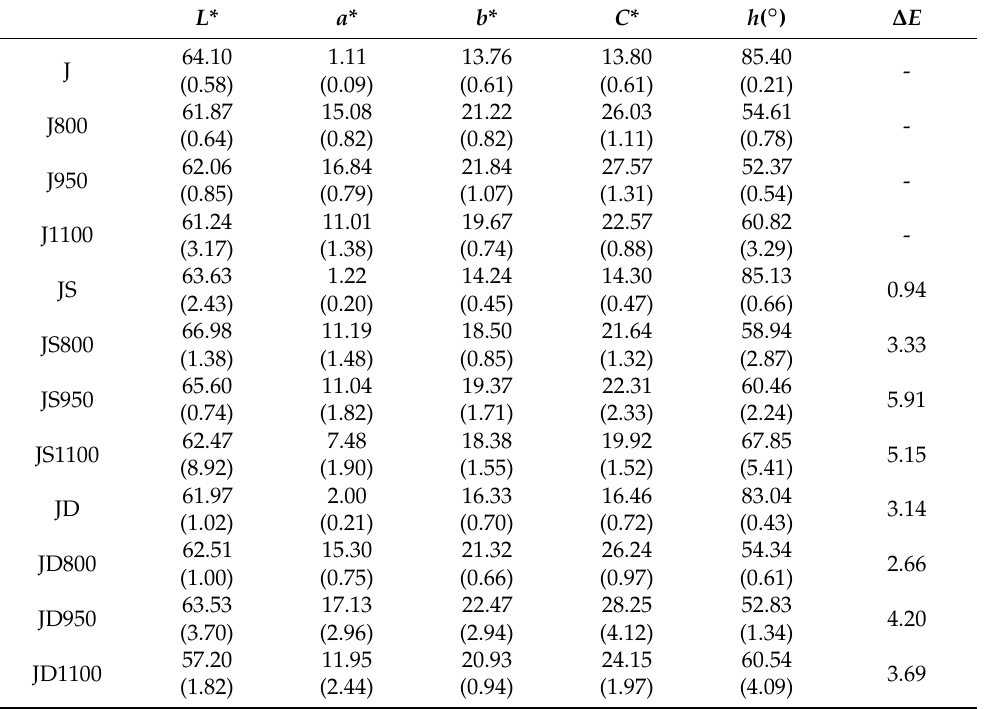
Table 5. Lightness ( L *), chromatic coordinates ( a * and b *), chroma ( C *), hue angle ( h ( ◦ )), and colour difference ( ∆ E ) values for unfired and fired ceramic samples with and without